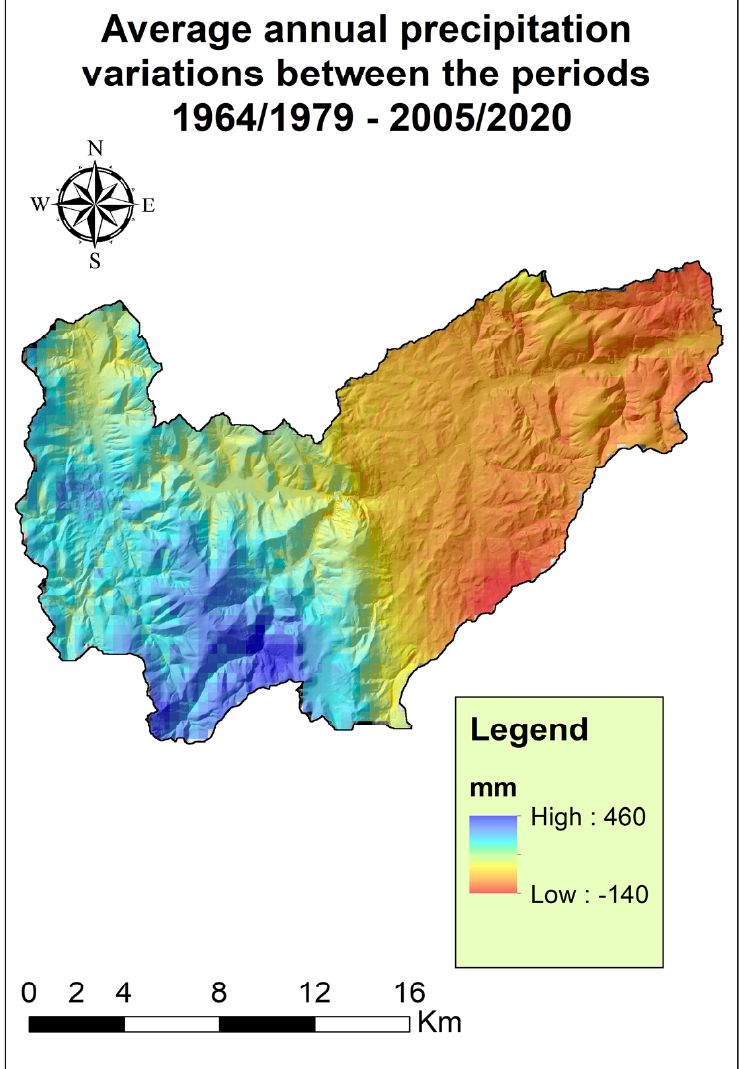
Figure 7. Variation in average annual precipitation between the periods 1964–1979 and 2005–2020.